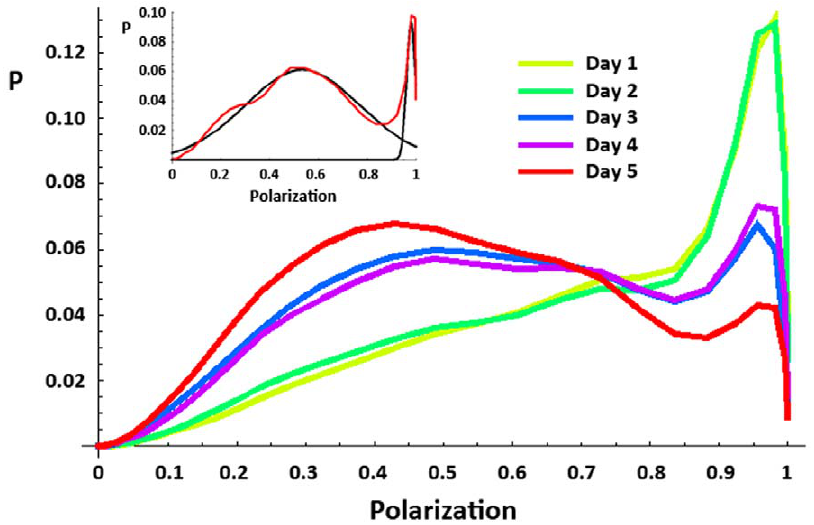
Figure 1. Density distributions of polarization by testing day for Experiment 1. Summed polarization distributions for repeated exposures to the testing tank on consecutive days. Distributions are averaged across the entire session (1800 frames per session) and over all groups (24 groups of 8 fish each). As fish habituate to the tank across days they spend more time shoaling (low polarization) and less time schooling (high polarization; K-S test, days 1–2 vs. days 3–5, all p , 0.0001; see Table S1). The inset shows a sample distribution from one complete session (1800 frames) (red) and its decomposition into schooling and shoaling modes (black), by fitting a Gaussian mixed model (see text). Note that each session’s distribution was tested for bimodality independently.